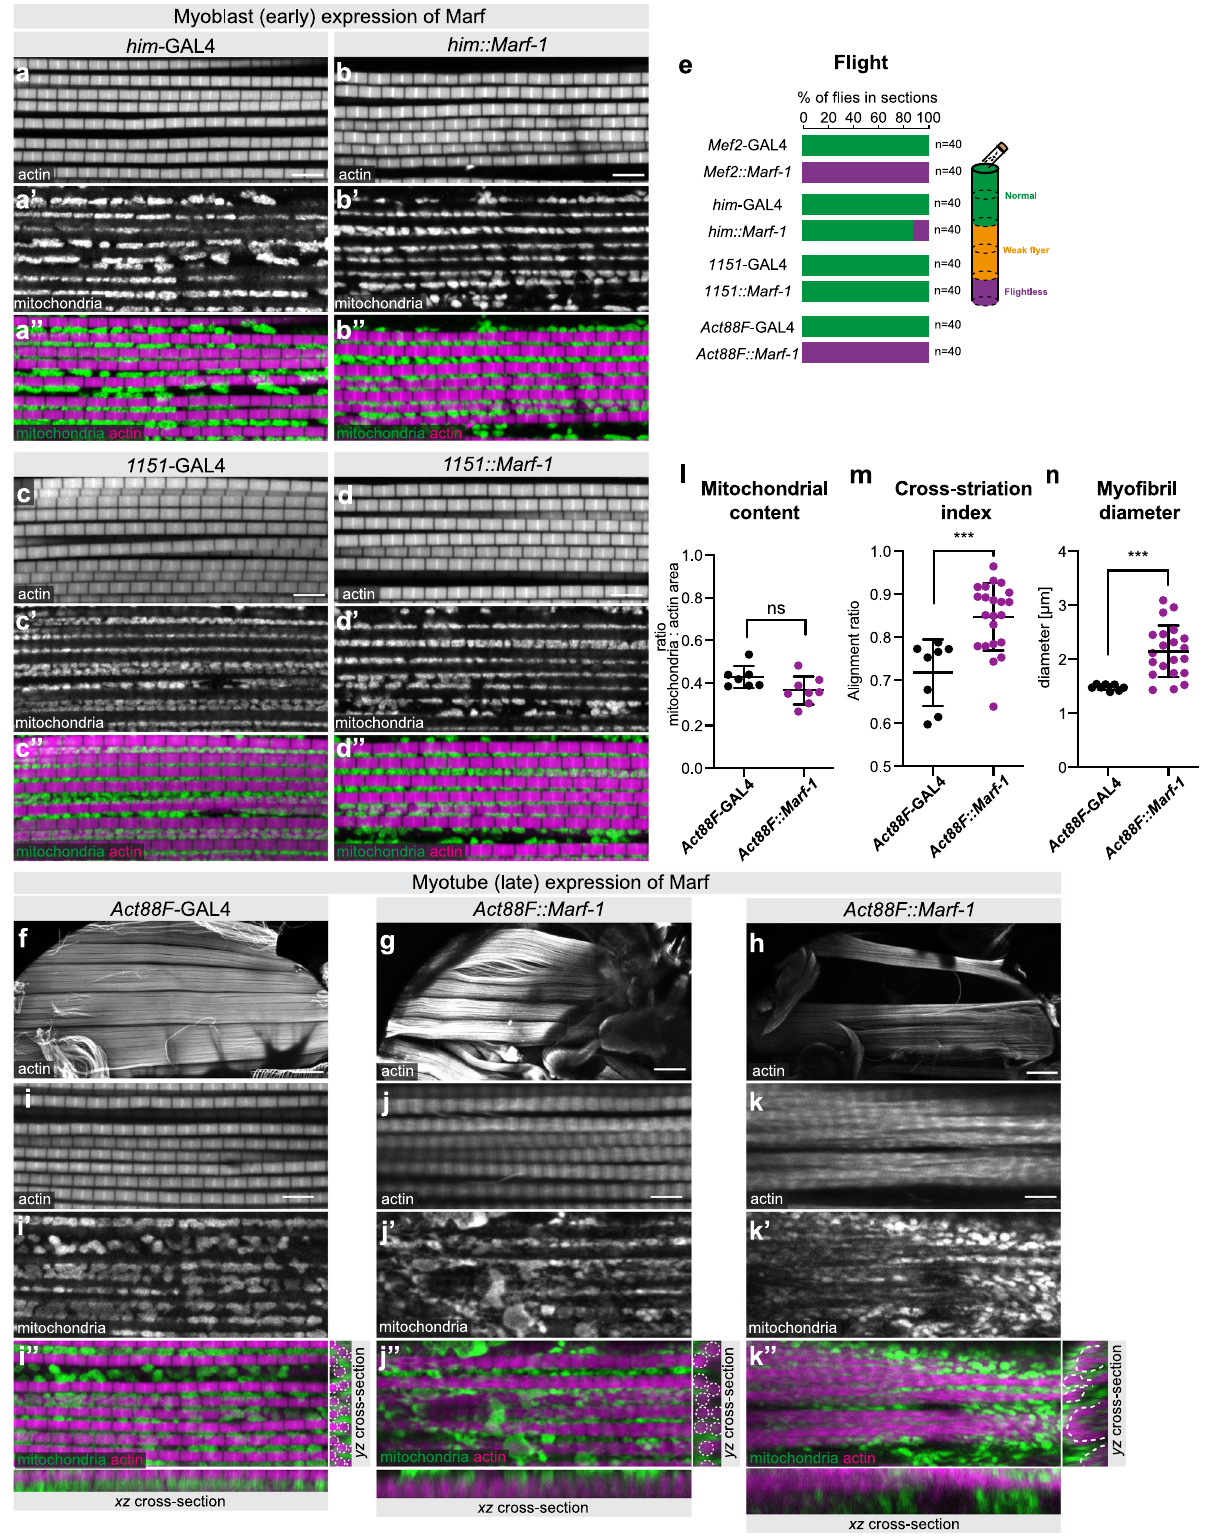
Developmental times indicated are the equivalent to the characterised ones at 27°C 36